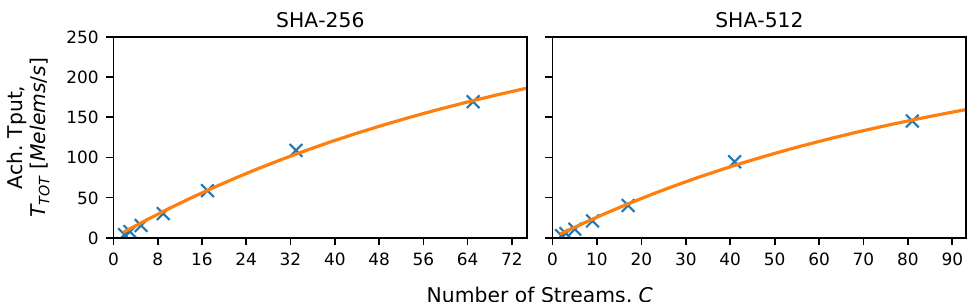
Figure A3. Calibrated total achievable throughput plot of the virtualized SHA-2 cryptographic hash application. This is for SHA-256 and SHA-512 with parameters N = C and S = 0 (i.e., no secondary memory). Data points are from 1 tool flow run. For SHA-256, the maximum number of pipeline stages is 65. For SHA-512, it is